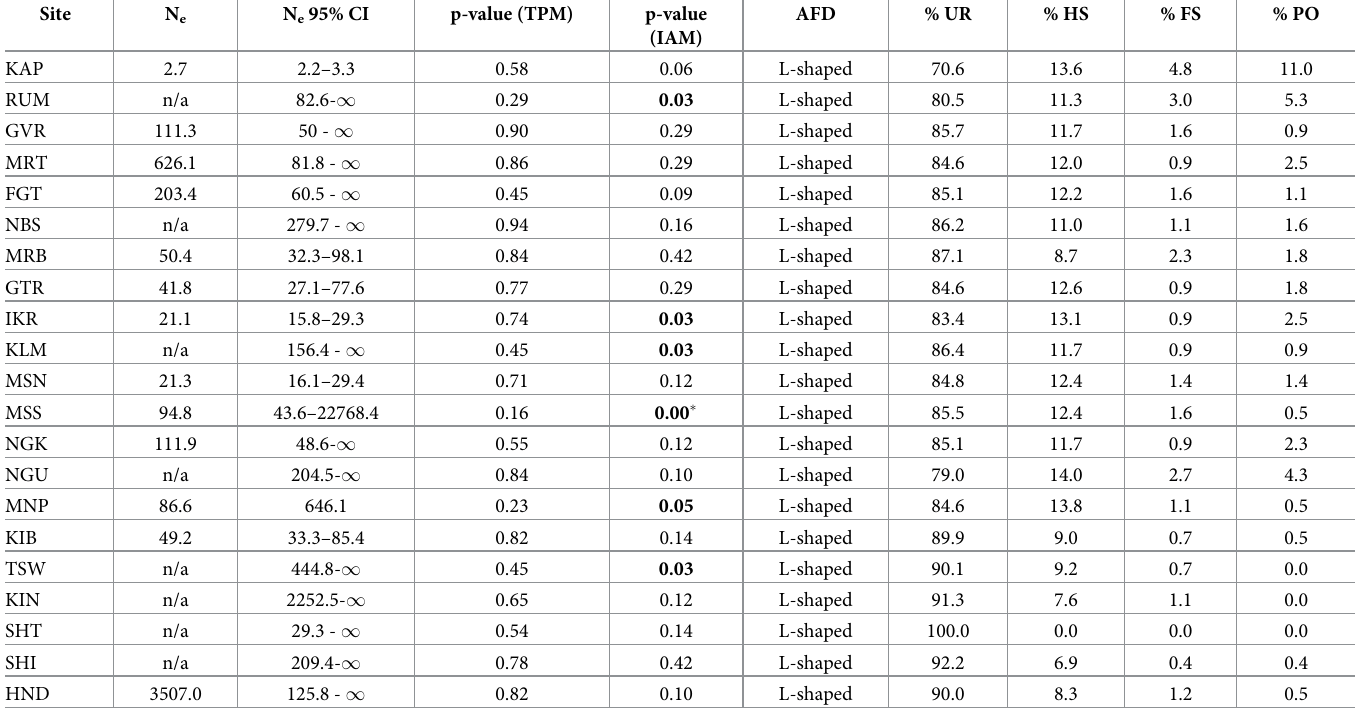
Table 2. Estimates of effective population size (N e ), bottleneck, and